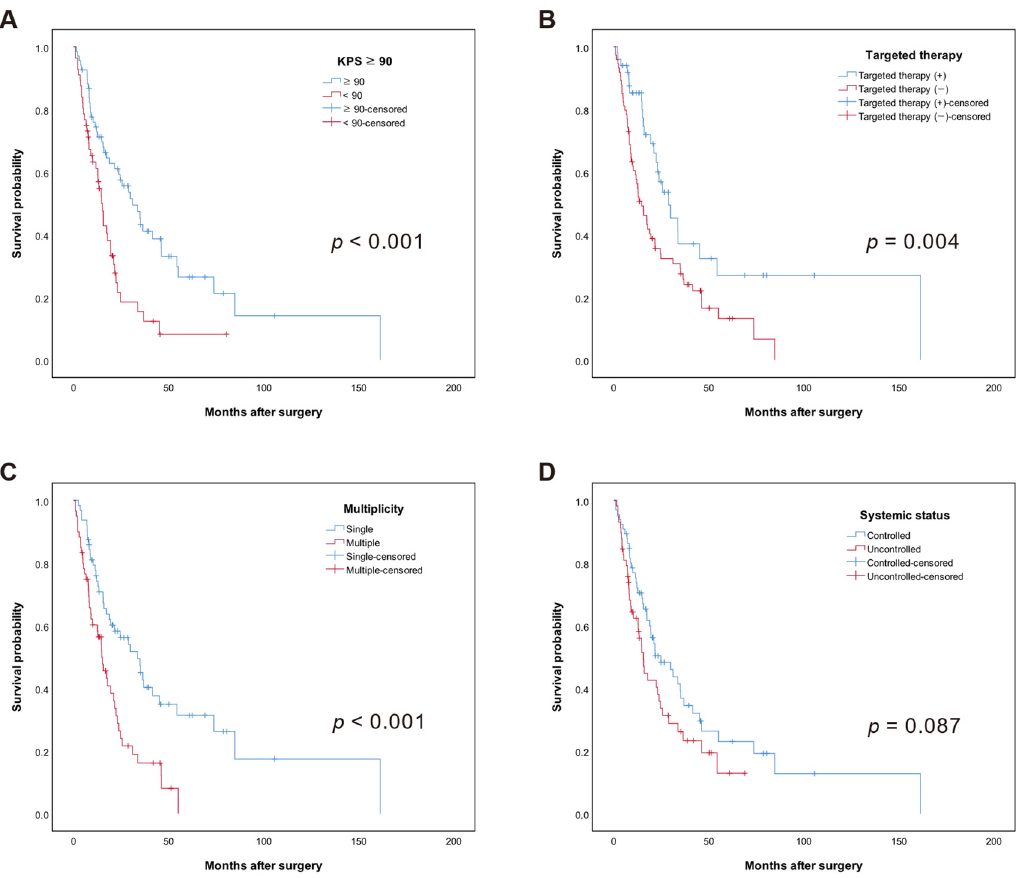
Figure 1. Kaplan–Meier curves of overall survival (OS) in months. The median OS in each group was as follows: ( A ) KPS score, median survival was 31.2 vs. 14.7, (KPS ≥ 90 vs. KPS < 90, p < 0.001), ( B ) use of targeted therapy, median OS was 28.9 vs. 13.4 ( p = 0.004), ( C ) multiplicity of brain metastases, median OS was 33.7 vs. 14.9 ( p < 0.001), ( D ) condition of systemic control, median OS was 24.9 vs. 15.6 ( p =